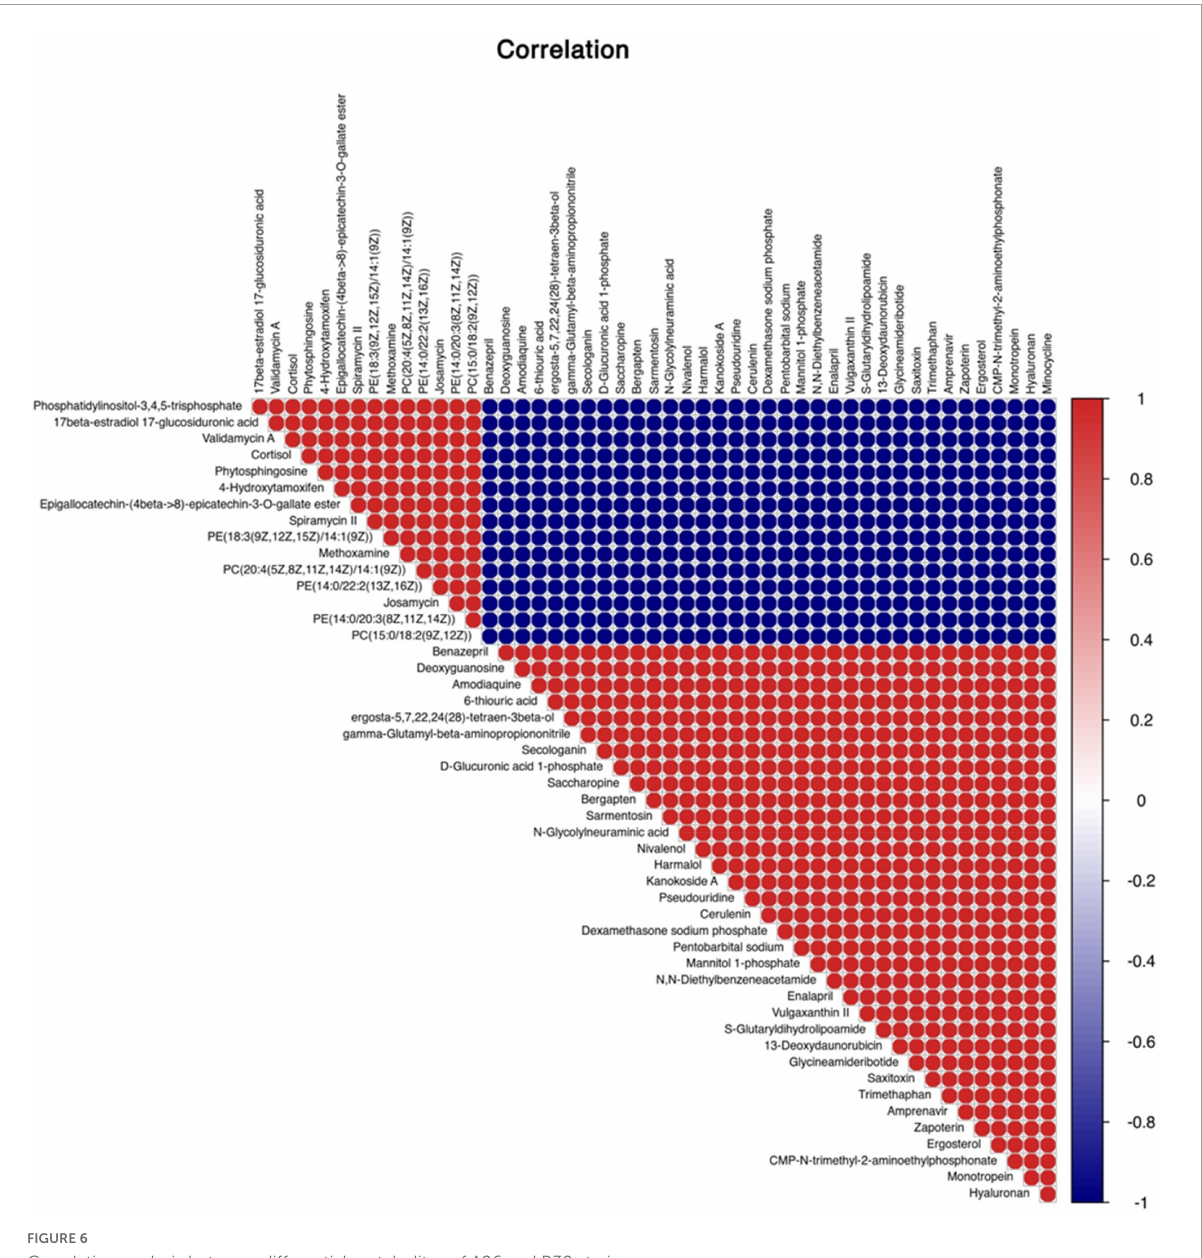
301,490,876 bp nucleotides with a mean contig length of 1697 bp, N50 of 2896 bp, and N90 of 690 bp. A